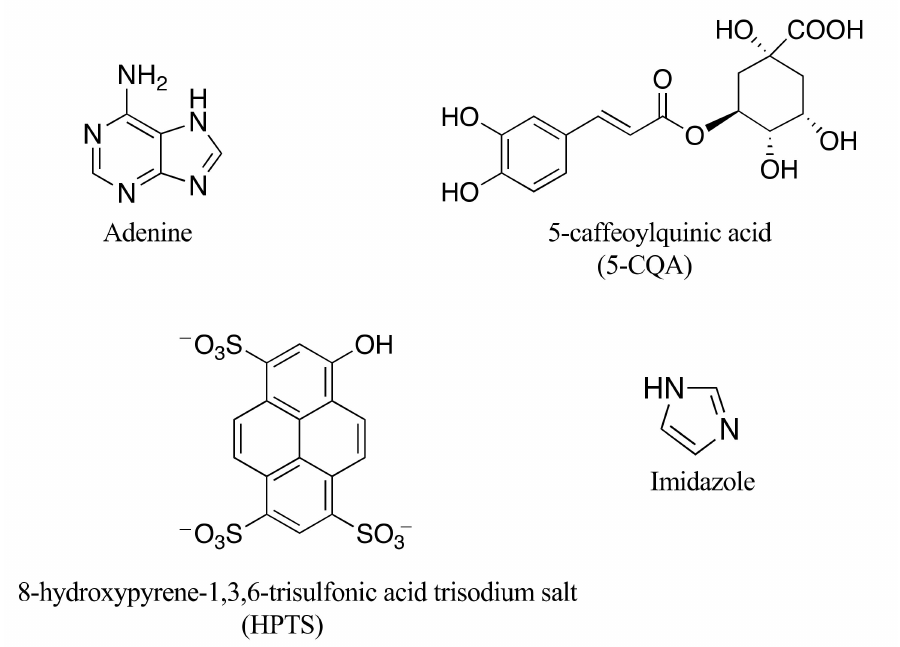
Figure 2. Molecules evaluated as potential binding units specific for